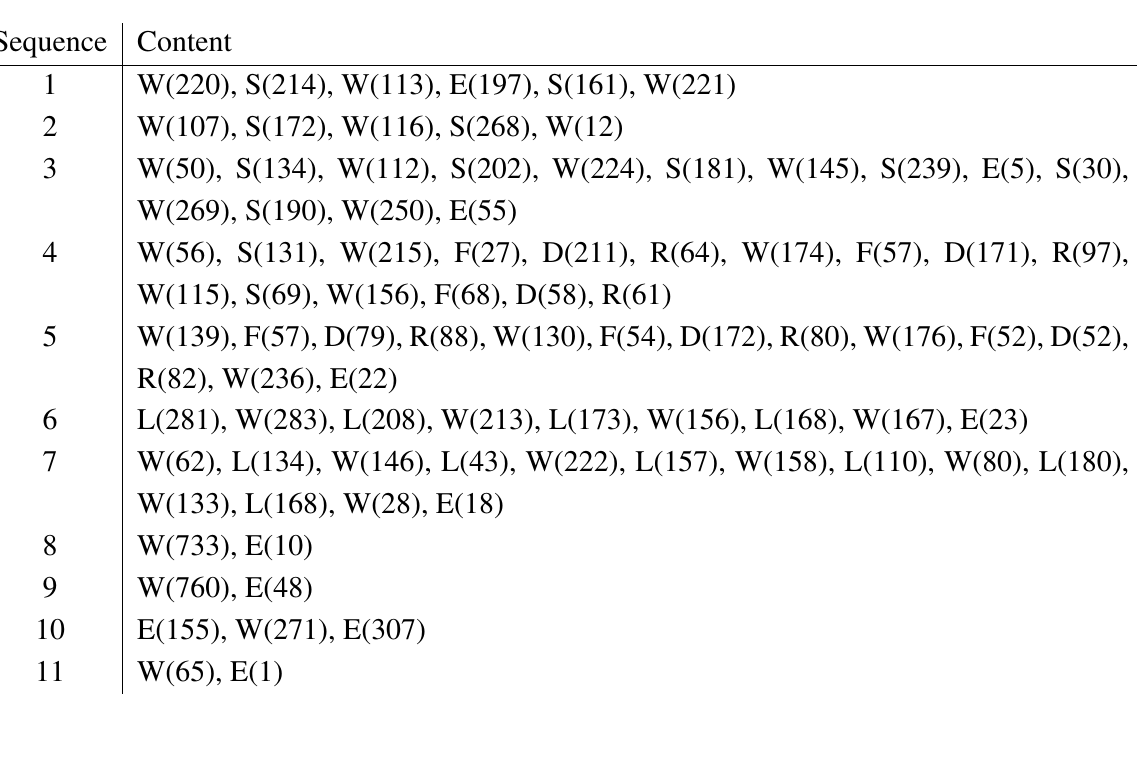
Table 3. Content of the sequences used. W stands for walking , S for stopped , F for falling , D for lyed down , R for rising , L for bending and E for error . The number of frames that the activity last is shown between parenthesis